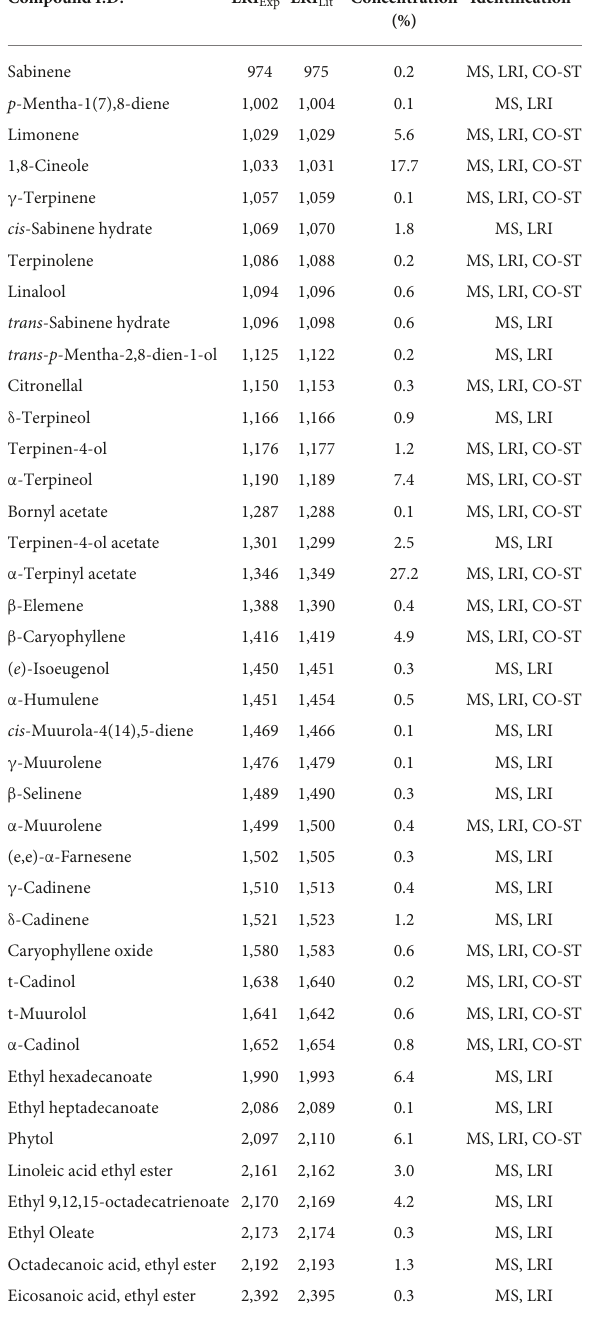
TABLE 1 Chemical compositions of MLE analyzed by GC-MS. Compound